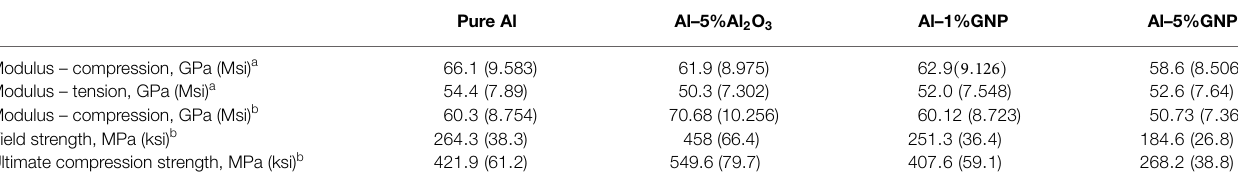
TABLE 2 | Summary of modulus from diametrical disk compression test